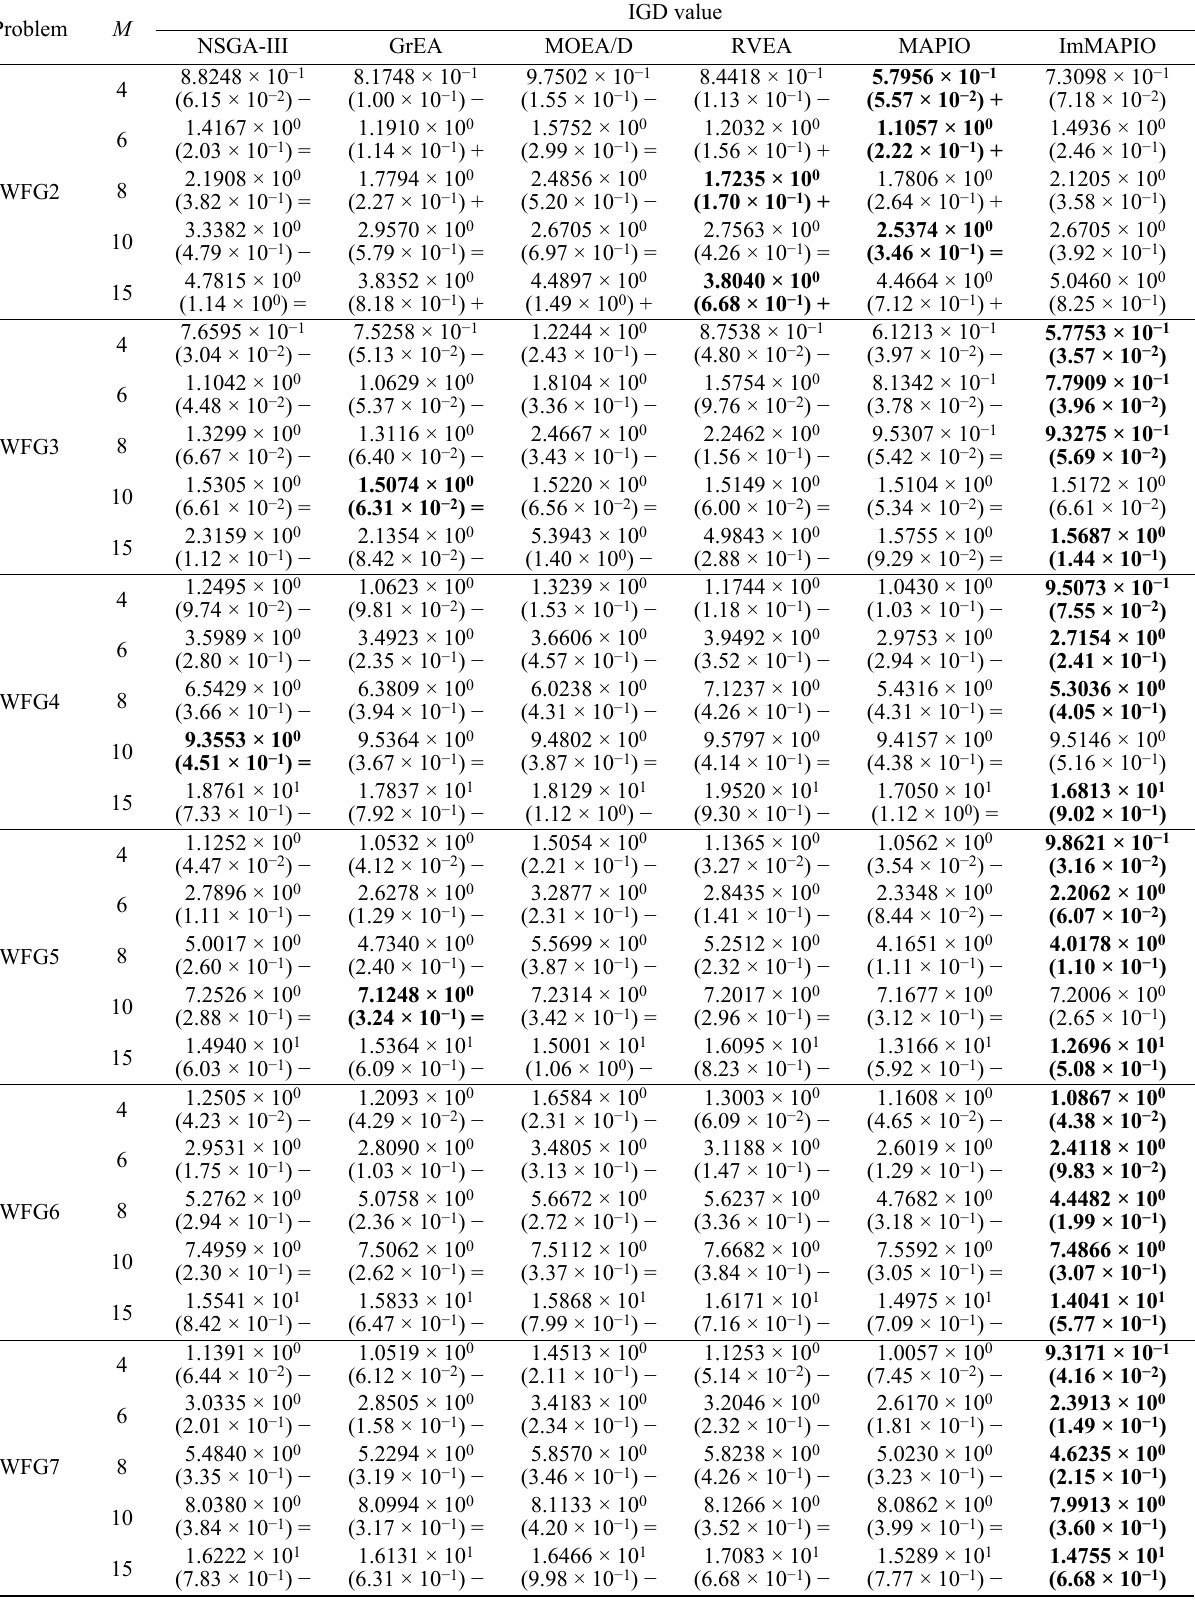
Table 4 IGD values of six algorithms for different objectives in the WFG test